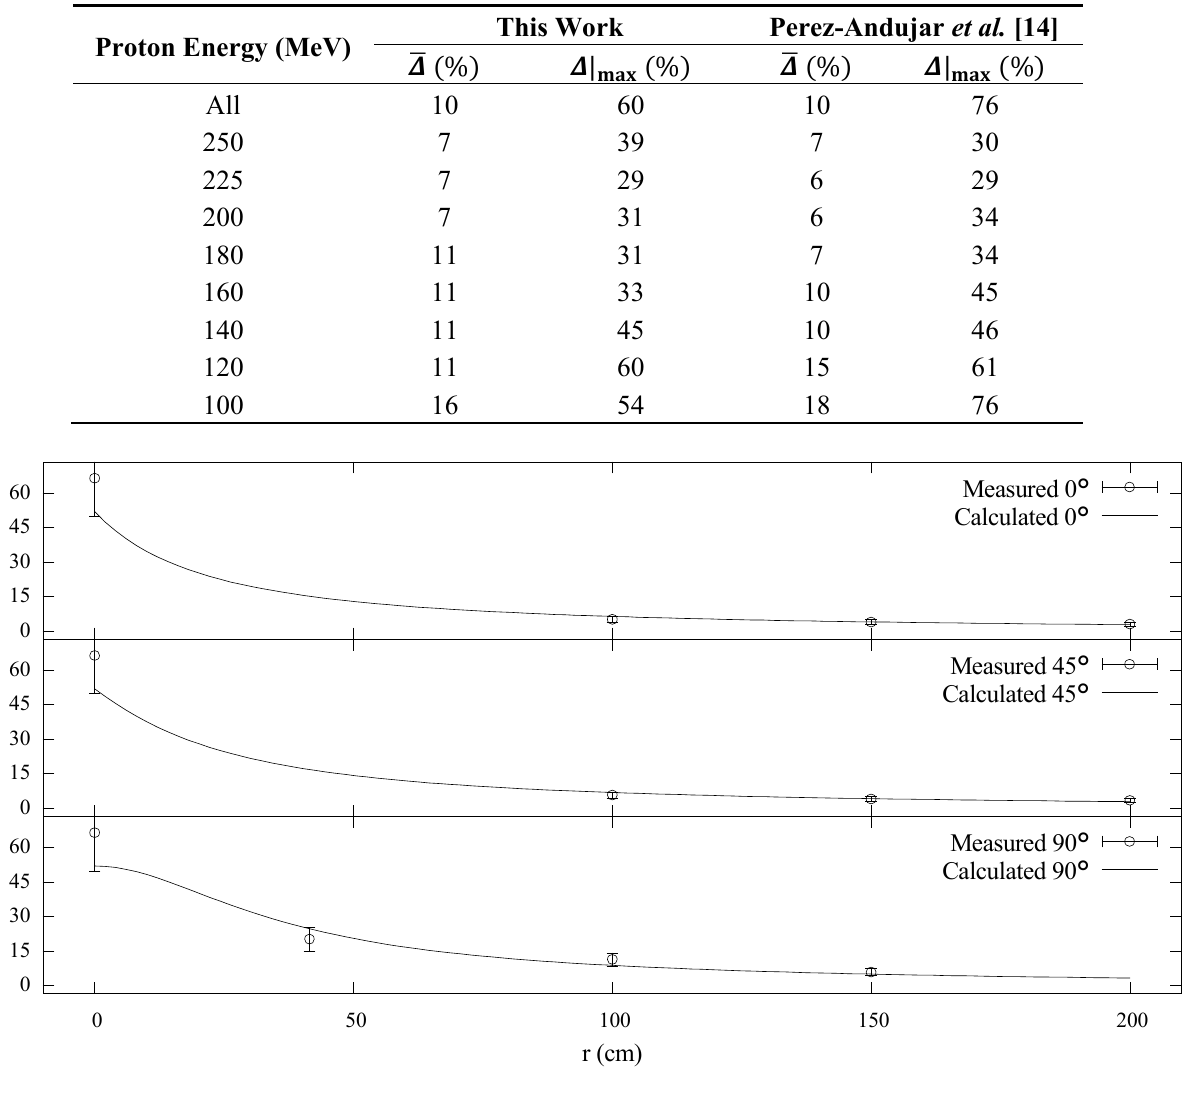
Table 4. Average local relative error ( 𝛥̅ ) and maximum local relative error ( 𝛥| analytical model of the general-purpose beamline from this work and Perez-Andujar et al. [14].